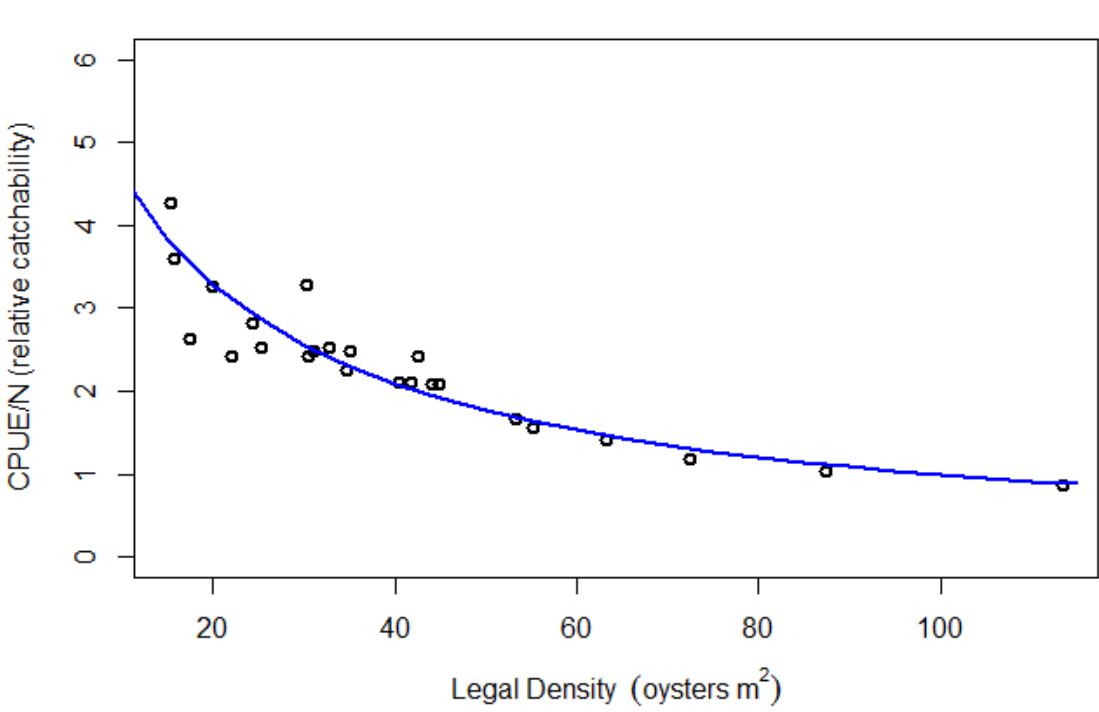
Figure A2.2. Density dependence in relative catchability q as evidenced by variation in mean annual catch per unit effort (CPUE), measured as trips per year divided by mean legal oyster density from DACS surveys. Assuming constant area swept per tong lift, this relationship implies that number of tong lifts per trip increases by a factor of about 4 when densities drop from around 100 legal oysters/m 2 to the observed low of near 10/m 2